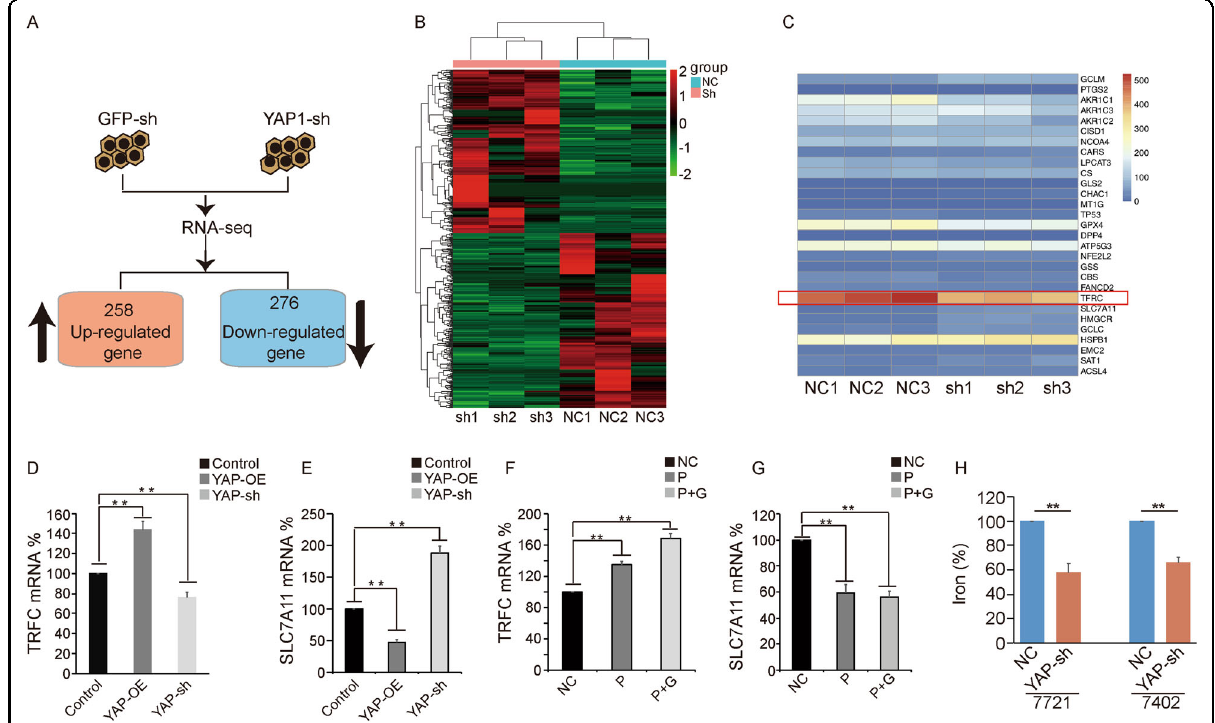
Fig. 3 YAP regulates iron metabolism by targeting TFRC. A Results of RNA-seq analysis in control and YAP knockdown SMMC-7721 cells. B The heat map demonstrates gene clustering with three biological replicates. Bright green indicates underexpression, and bright red indicates overexpression. C Ferroptosis-related genes were selected to generate a new integrated heat map according to the RNA-seq data. D and E Transcription levels of TFRC ( D ) and SLC7A11 ( E ) were veri fi ed by qPCR in SMMC-7721 cells with YAP overexpression or knockdown. F and G Transcription levels of TFRC ( F ) and SLC7A11 ( G ) were measured by qPCR in SMMC-7721 cells treated with PUGNAc with or without GlcNAc. H The concentration of iron was determined in Bel-7402 and SMMC-7721 cells with YAP